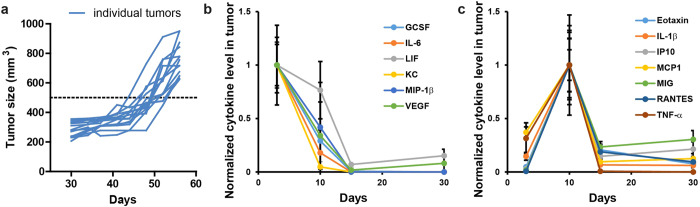
Tumor growth dynamics and intratumor cytokine response to CAF elimination.(a) In an 8-week in vivo study of MDA/Luc+CAF-iCasp tumor growth, tumor size does not demonstrate visible changes until 43~53 days into the experiment measured by an arbitrary threshold (500 mm3). (b) A collection of host (mouse) cytokines with peak level at day 3 followed by steady decline into day 30. (c) A collection of host cytokines with initial increase to peak level at day 10 followed by steady decline into day 30.